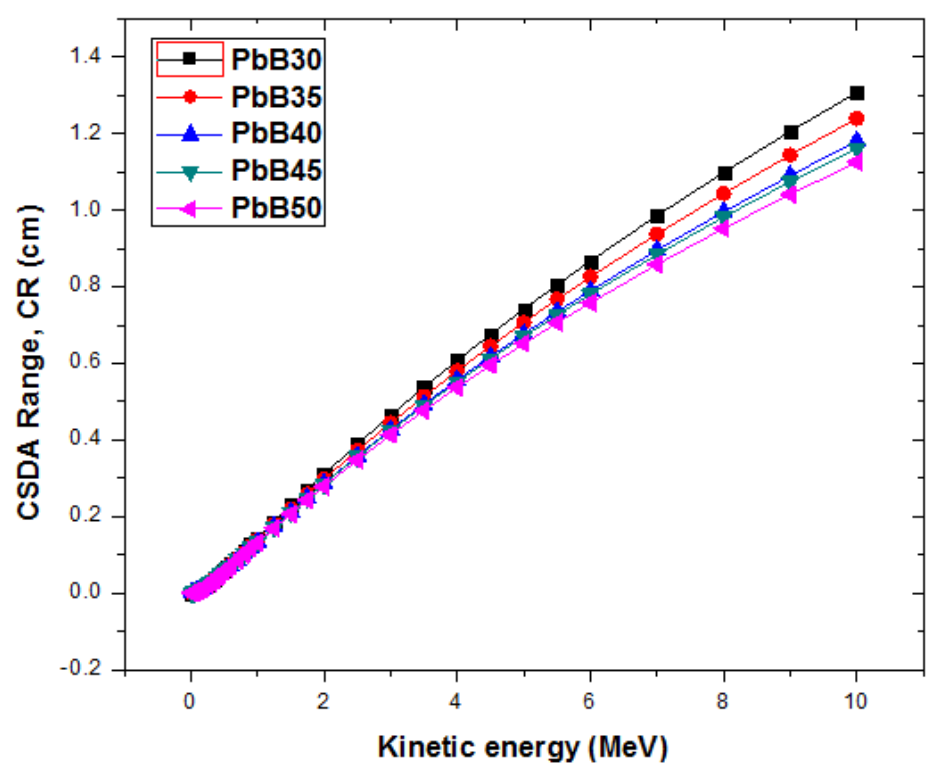
Figure 12. CSDA range of PbB-glasses.